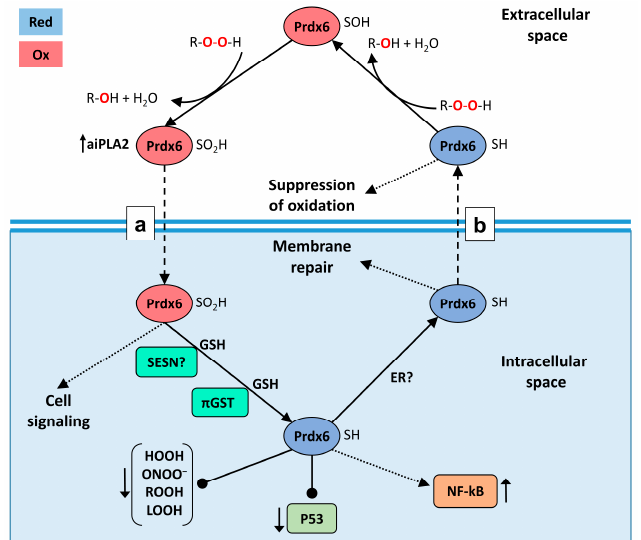
Figure 8. A hypothetical chart of Prdx6 “recirculation” between the cell and the extracellular space, and the role of the phospholipase activity (aiPLA2) in this process. ( a ) Penetration of Prdx6 into the cell; ( b ) secretion of Prdx6 into the extracellular space. The oxidized form of Prdx6 can influence intracellular processes and, after going through reduction steps, can be involved again in antioxidant defense. Glutathione (GSH), sestrins (SESN), and/or others redox-enzymes are involved in the reduction of the oxidized Prdx6-SO 2 H form. Prdx6-SOH is being reduced with the participation of GSH and glutathione-S-transferase π ( π GST). The reduced form of Prdx6 is involved in the suppression of cell membrane oxidation and the reduction of oxidized phospholipids. The reduced (Red) form of Prdx6 is shown in blue, the oxidized (Ox) form is in red. ER–endoplasmic reticulum. Dotted arrows denote an indirect action. Normal arrows denote direct actions. Arrows with a bold dot denote